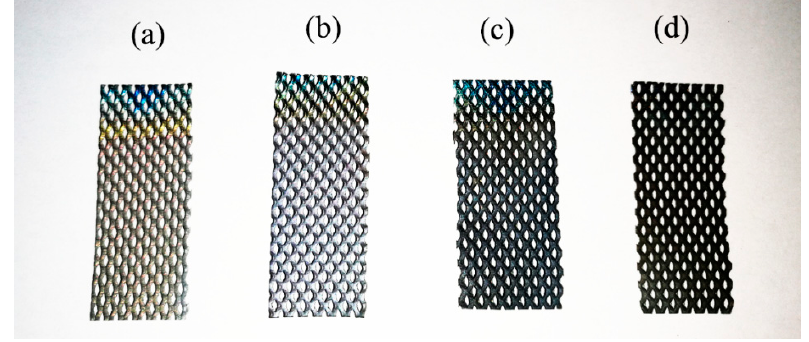
Figure 1. Digital pictures of ( a ) TiO 2 nanotubes (NTs); ( b ) TiO 2 NTs/Ag; ( c ) TiO 2 NTs/MoS 2 ; and ( d ) TiO 2 NTs/Ag/MoS 2 mesh. and ( d ) TiO 2 NTs/Ag/MoS 2